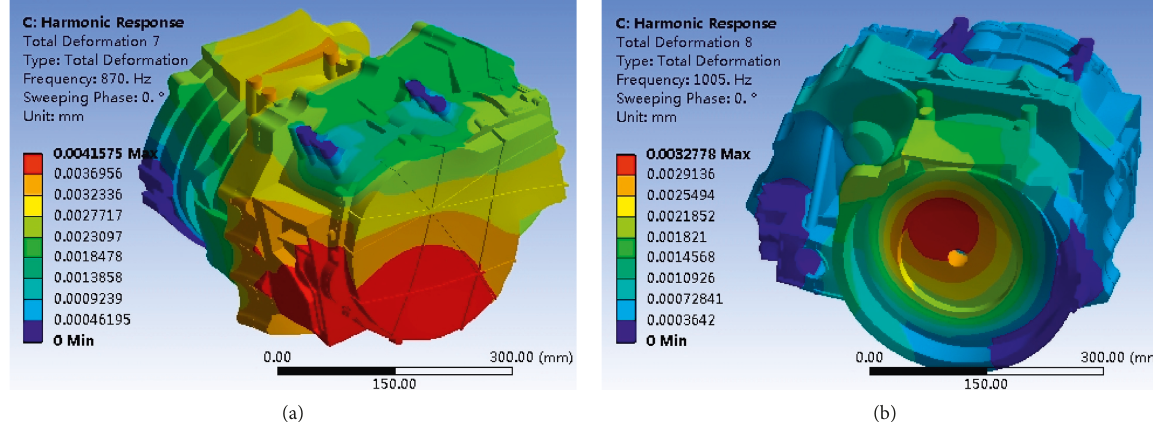
Figure 7: Vibration response of the housing surface. (a) The 3rd natural frequency (870 Hz). (b) The 4th natural frequency (1005Hz).